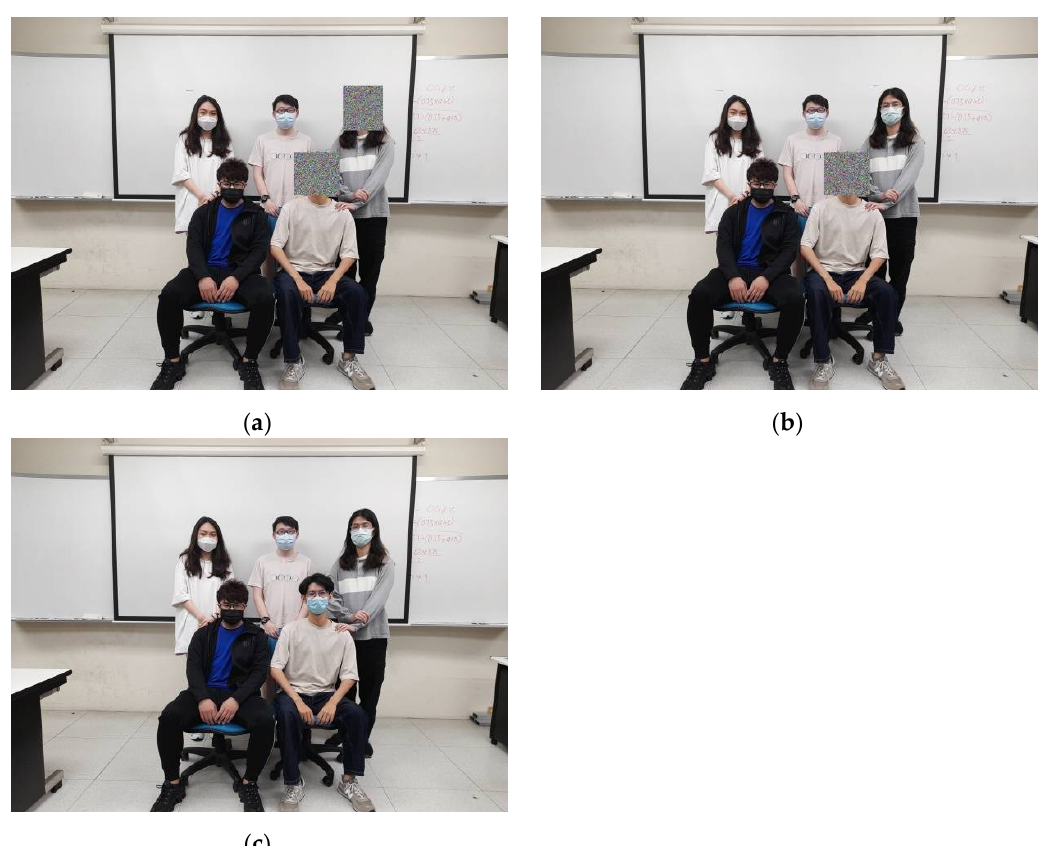
Figure 4. Images of accessible classes C 1 , C 2 , and C 3 decrypted by SK 1 , SK 2 , and SK 3 , respectively. ( a ) class C 1 ; ( b ) class C 2 ; ( c ) class C 3 .